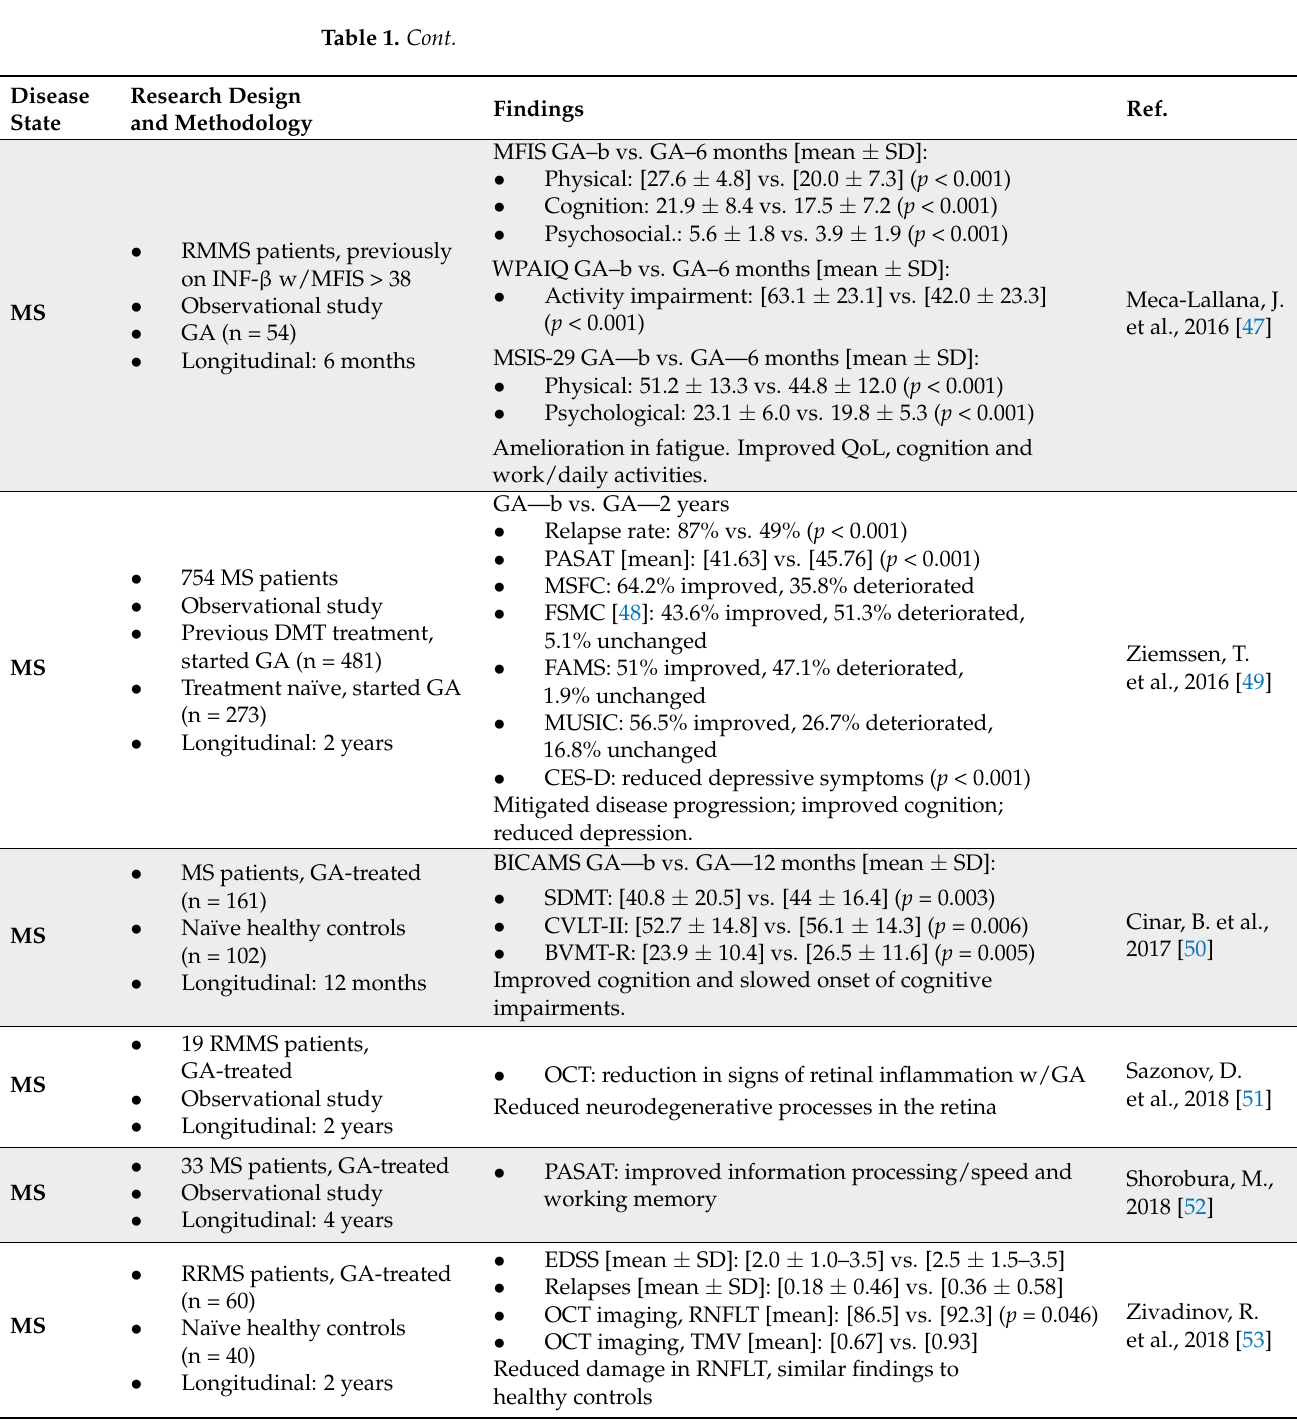
Table 1. Cont. Findings